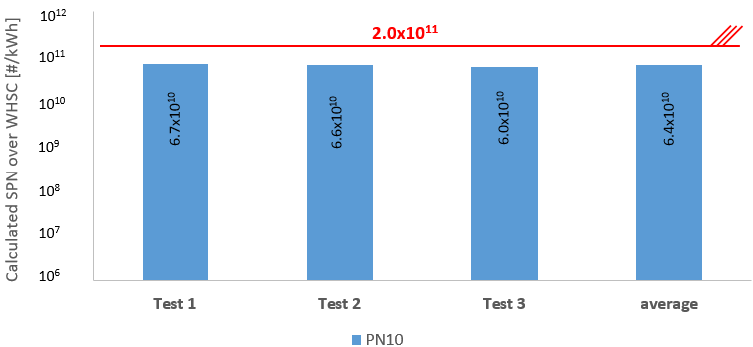
Figure 12. Calculated solid particle number results of each individual test, with DPF compared to Euro VII proposal; * 2.0 × 10 11 = Euro VII proposal PN10 limit.